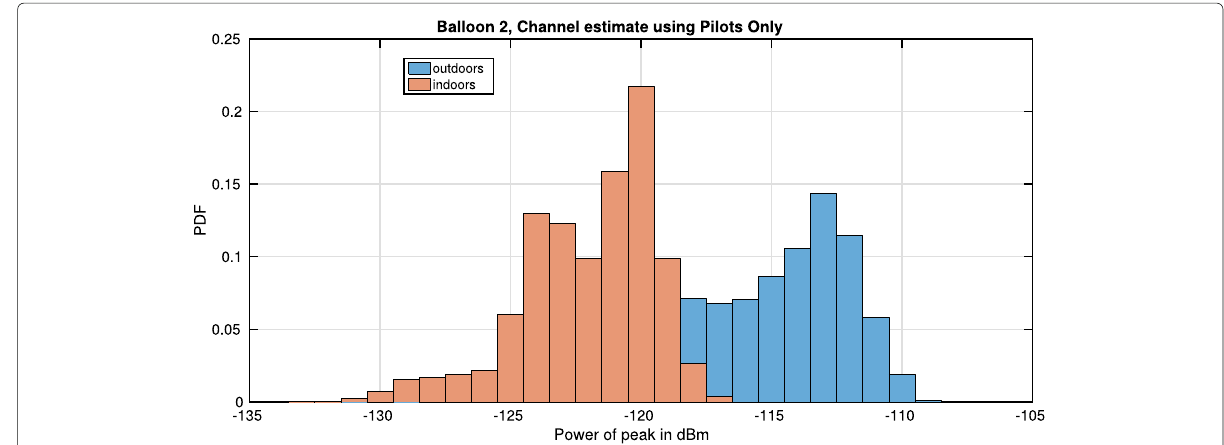
Fig. 13 Signal power distribution from Loon HAP 2 (~25 km away), indoor vs